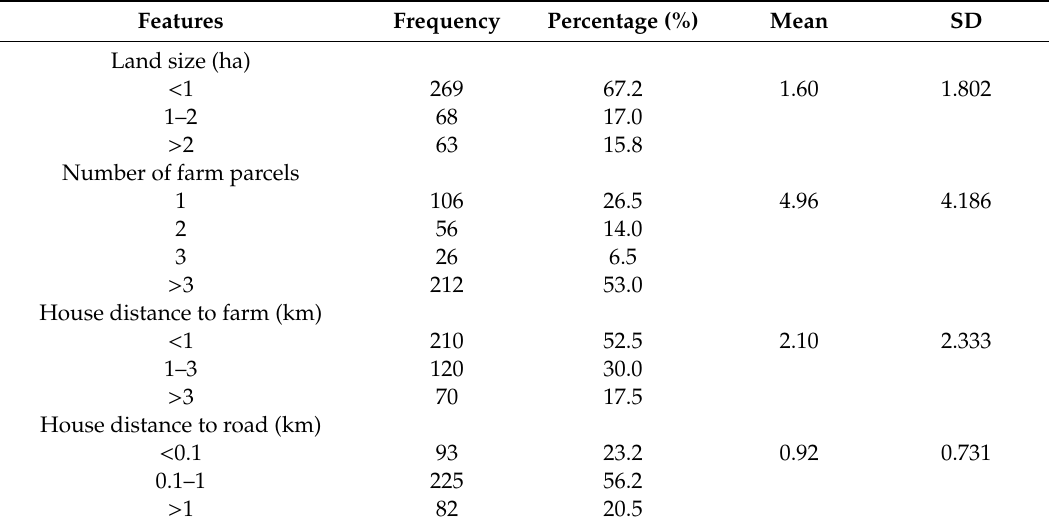
Table 3. Technical aspects of rice growers in Rudsar County ( n =